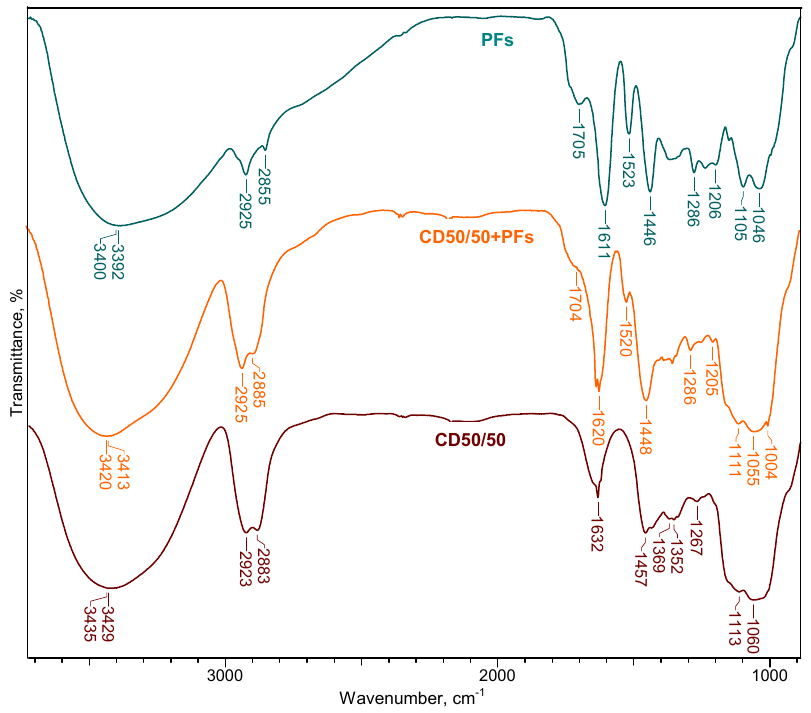
Figure 5. ATR-FTIR spectra of PFs, CD50/50 hydrogel and PFs-loaded hydrogel: CD50/50 + PFs. The main characteristic ATR-FTIR absorption bands of PFs are: 3391 cm − 1 for OH stretching vibration, 2924 cm − 1 for CH stretching vibration, 1705 cm − 1 for C-O stretching vibration, 1611 cm − 1 for C-C stretching vibration, 1445 cm − 1 for CH 2 bending vibrations, 1285 cm − 1 and 1206 cm − 1 for C-O stretching vibration (aryl ether band), 1105 cm − 1 for C-O-C stretching vibration (alkyl ether band) and 1046 cm − 1 for C-O stretching vibration (alkyl substituted ether)